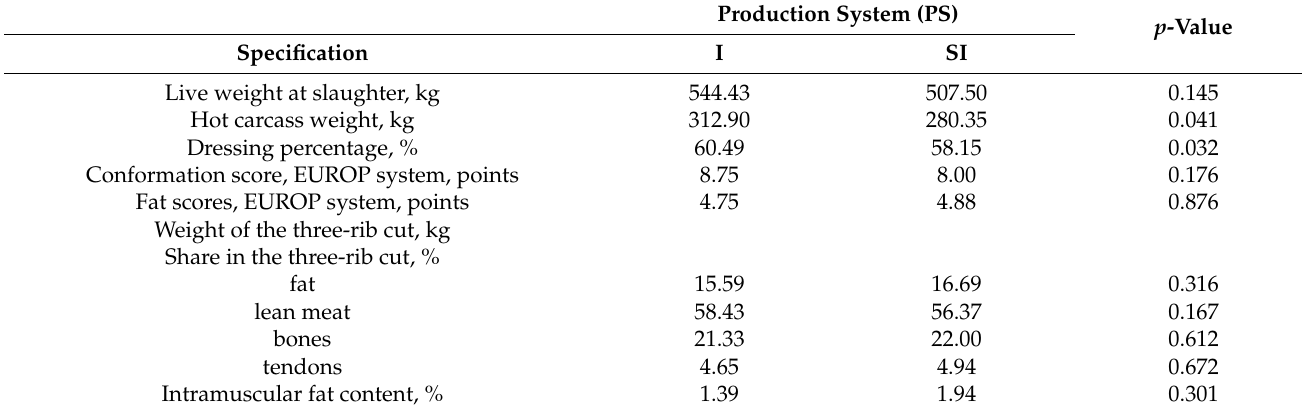
Table 3. Characteristics of bull carcasses in intensive and semi-intensive production systems.